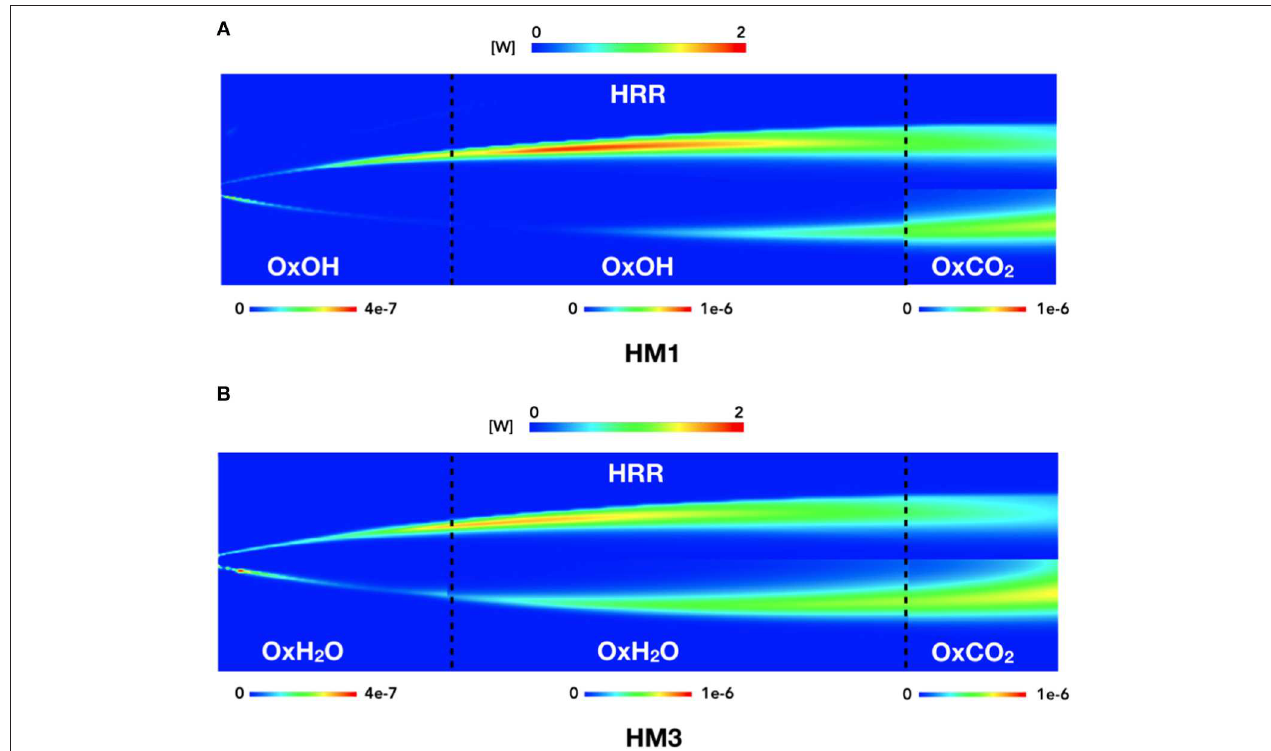
FIGURE 10 | HM1 and HM3 contour plots of HRR compared to species products contours. The three zones are split as follows: from 0 to 150 mm, from 150 to 450 mm, and from 450 to 550 mm.